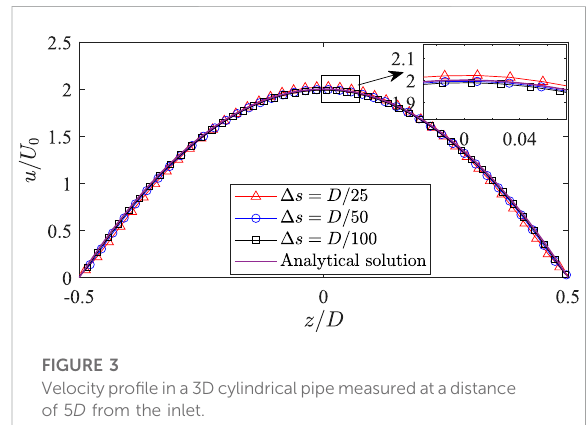
FIGURE 3 Velocitypro fi leina3Dcylindricalpipemeasuredatadistance of 5 D from the inlet.